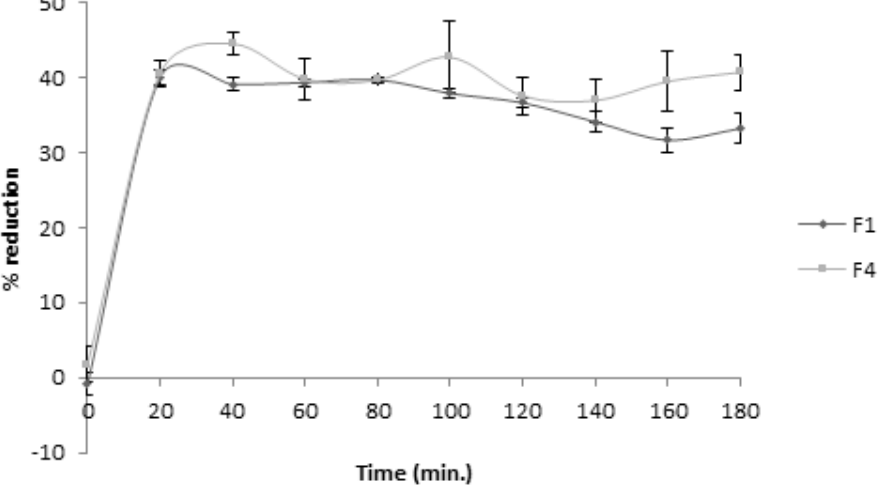
Figure 6. Antioxidant activity evaluation of the formulations after gastric juice action.